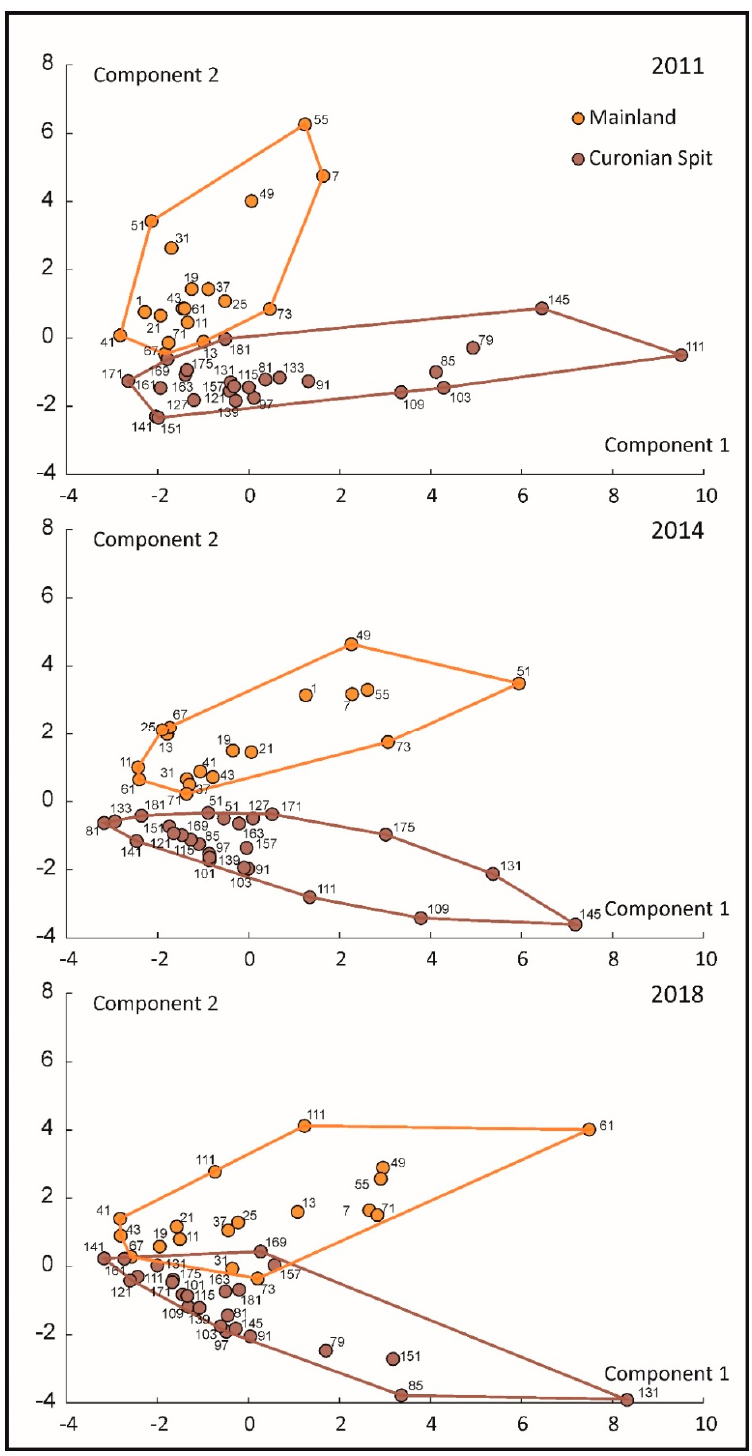
Figure 8. Principal component analysis after normalized varimax rotation, and factorial scores showed according to geographical location (Curonian Spit and mainland coast) in 2011, 2014, and 2018.